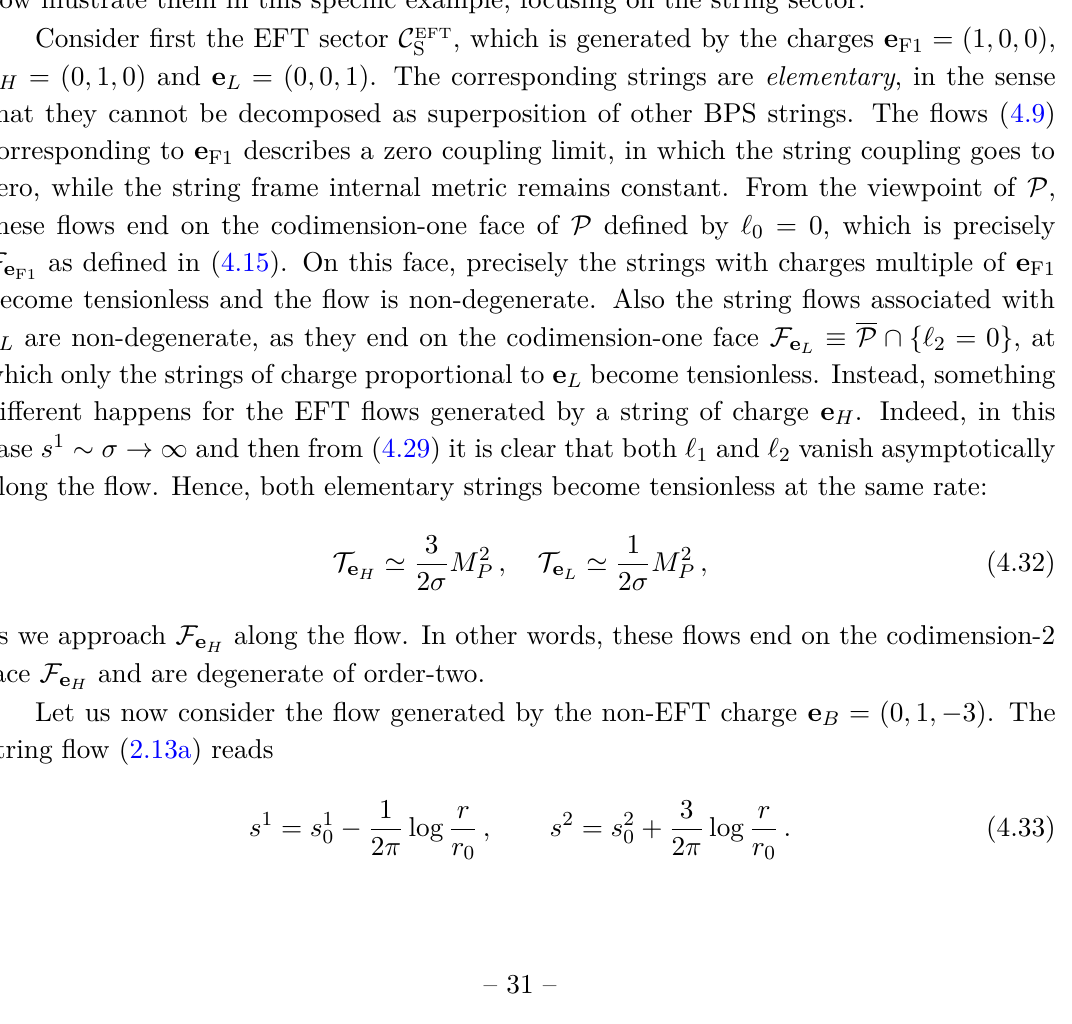
Figure 4 . BPS and EFT string and instanton lattice cones C EFT two-moduli heterotic